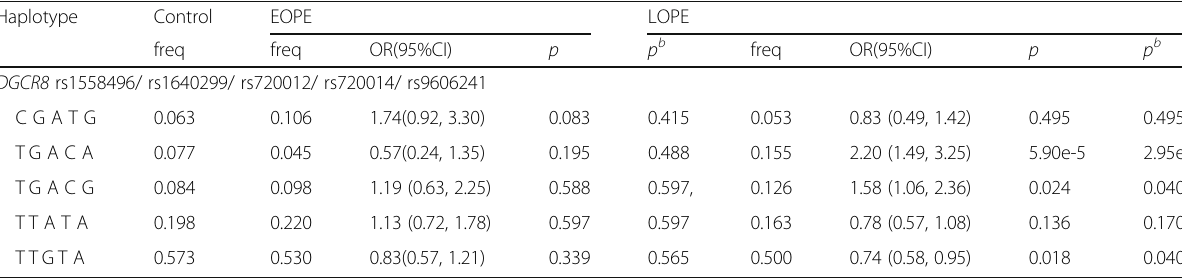
Table 3 Associations between haplotypes of DGCR8 genes and preeclampsia subtypes a Haplotype Control EOPE LOPE freq